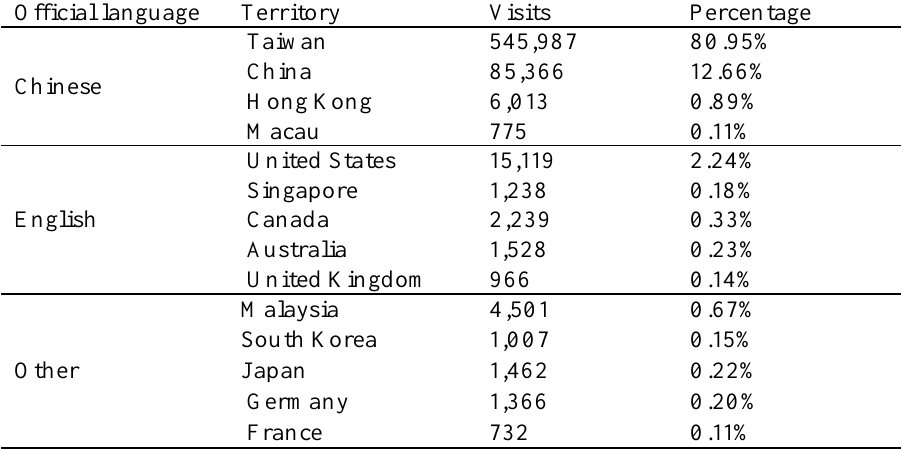
The Official Language Analysis of the The Top 15 Countries/Territories Official